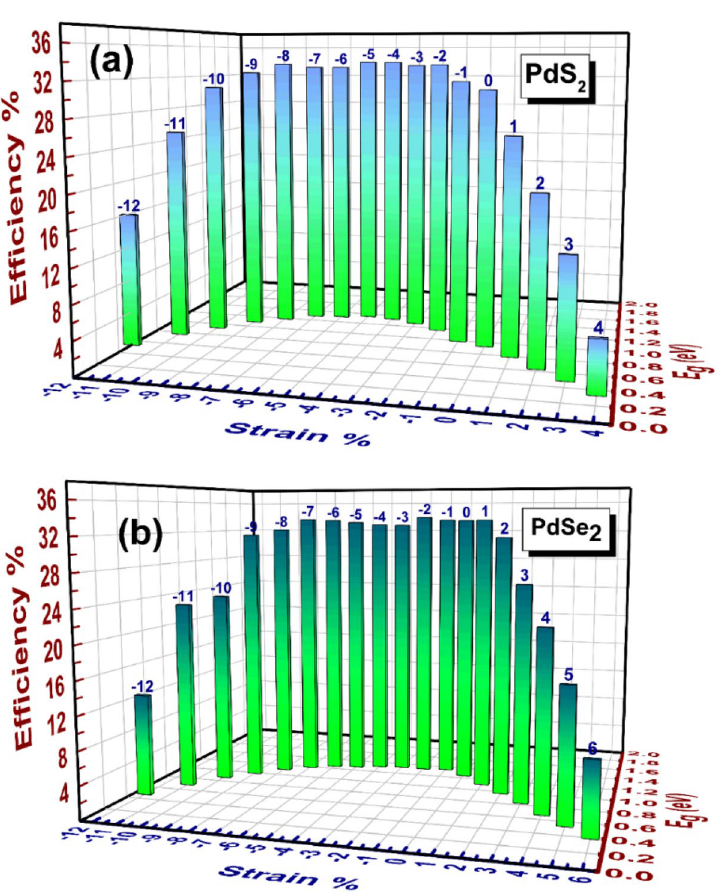
Figure 8. Change in SQ Efficiency η ( % ) of penta-PdQ 2 monolayers for pristine and loaded strain at T = 300 K ( a ) For penta-PdS 2 and ( b ) For penta-PdSe 2